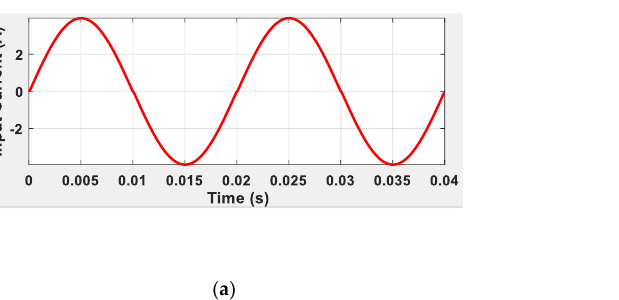
Figure 14. For various output frequencies without output voltage regulation capabilities: ( a ) input current waveform; ( b ) its FFT spectrum.